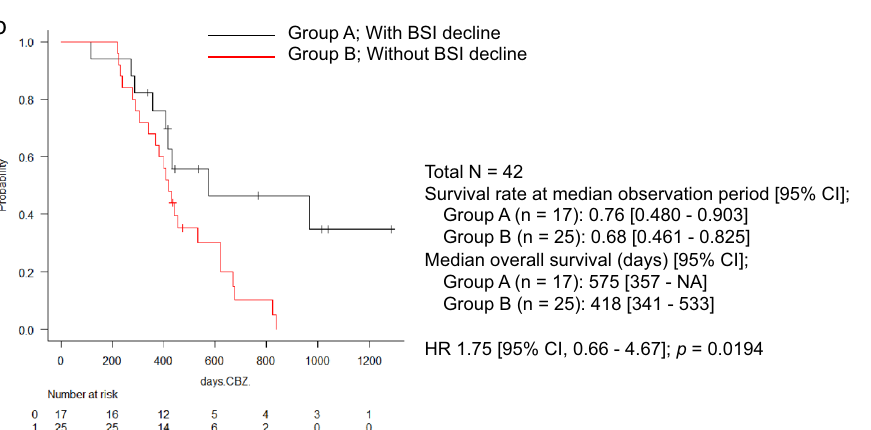
Figure 4. a Waterfall plots of percent change in bone scan index (BSI) after cabazitaxel treatment. Group A, CTC (−) / AR-V7 (−); Group B, CTC ( +) / AR-V7 (−); Group C, CTC ( +) / AR-V7 ( +) (N = 41). A vs. B, p = 0.697; B vs. C, p = 0.560; A vs. C, p = 0.433. b Kaplan–Meier curve of overall survival (OS) rate of patients with CRPC after cabazitaxel treatment, with or without bone scan index (BSI) reduction response. Group A, patients with BSI decline; Group B, patients without BSI decline (log-rank test) (N = 42). Survival rate at median observation period [95% CI]: Group A (n = 17), 0.76 [0.480–0.903]; Group B (n = 25), 0.68 [0.461–0.825]. Median overall survival (days) [95% CI]: Group A (n = 17), 575 [357–NA]; Group B (n = 25), 418 [341–533]. HR 1.75 [95% CI, 0.66–4.67], p = 0.0194. AR-V7, androgen splicing variant-7; BSI, Bone Scan Index; CI,